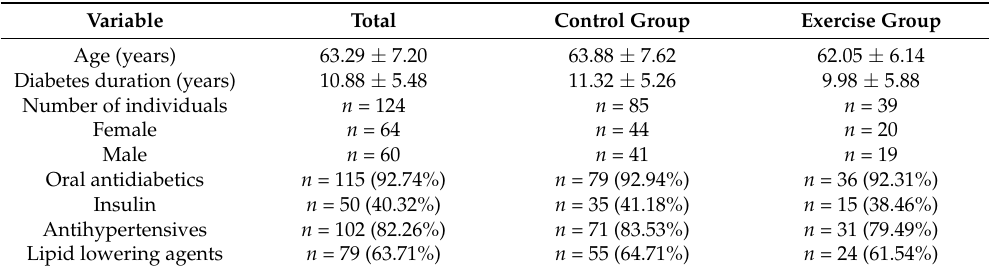
Table 1. Participants’ characteristics and pharmacological